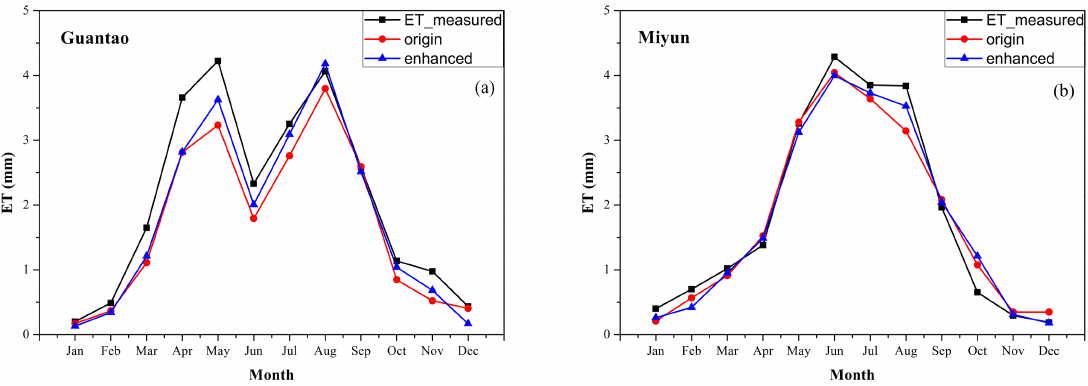
Figure 6. Variation in the monthly averaged ET from both methods and EC measurements at stations Guantao ( a ) and Miyun ( b ).